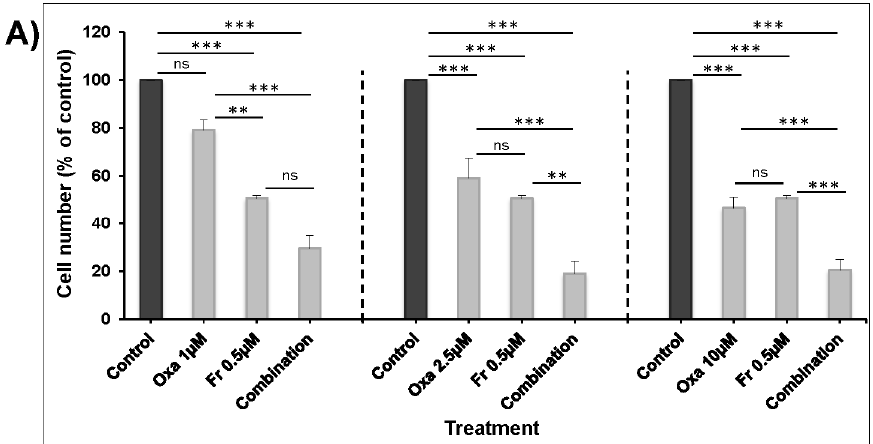
Table 1. IC 50 (µM) of Frondoside A compared to oxaliplatin and 5-fluorouracil at 48 h of treatment. IC 50